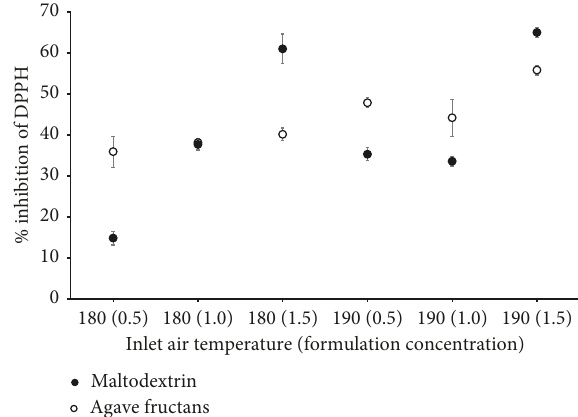
Figure 2: Percentage of inhibition for powders in which two types of carrier agents (MD and FOS) were